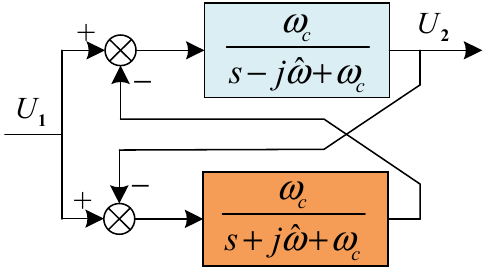
Figure 8. Block diagram of complex filter structure.